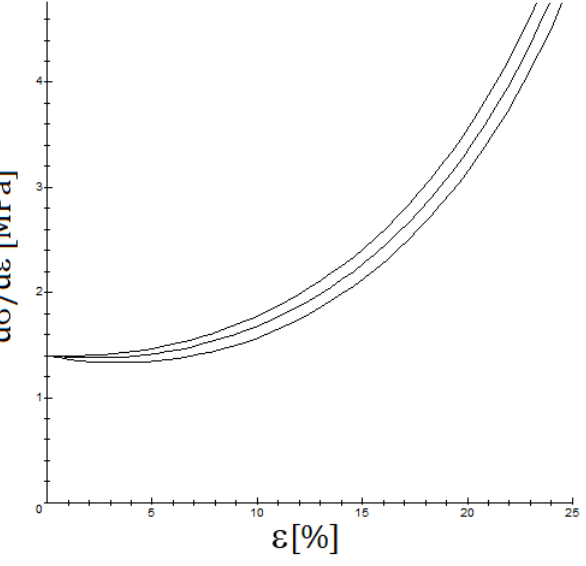
Figure 8. The influence of the strain rate on stiffness for ˙ ε = 0.1/ τ 0 ,0,2/ τ 0 y 0,5/ τ 0 (the upper curve is given for the highest and the lower curve for the lowest strain rate); the values used are b 0 = 8, c = 0.10, g 1 =